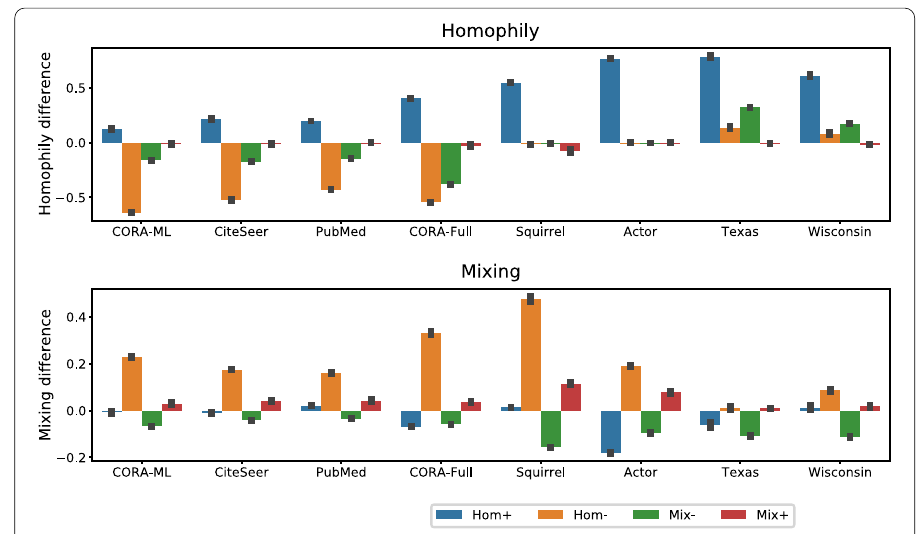
Fig. 1 Homophily and mixing measurements of the manipulated graphs. Here we show the change in homophily and mixing of the manipulated graphs comparing to the original graphs of each dataset. We can see that the intuitions we mention in our discussion in “Datasets” section are